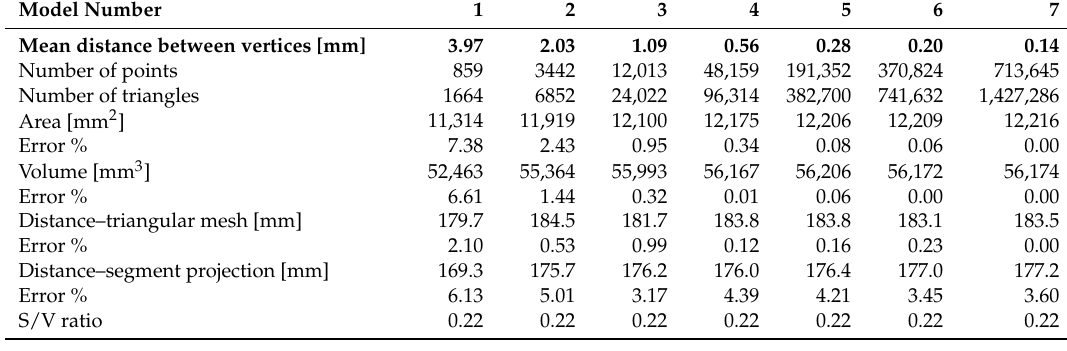
Table 2. Results of calculating the area, volume, and the distances between points depending on the resolution of the triangular mesh used in various models.